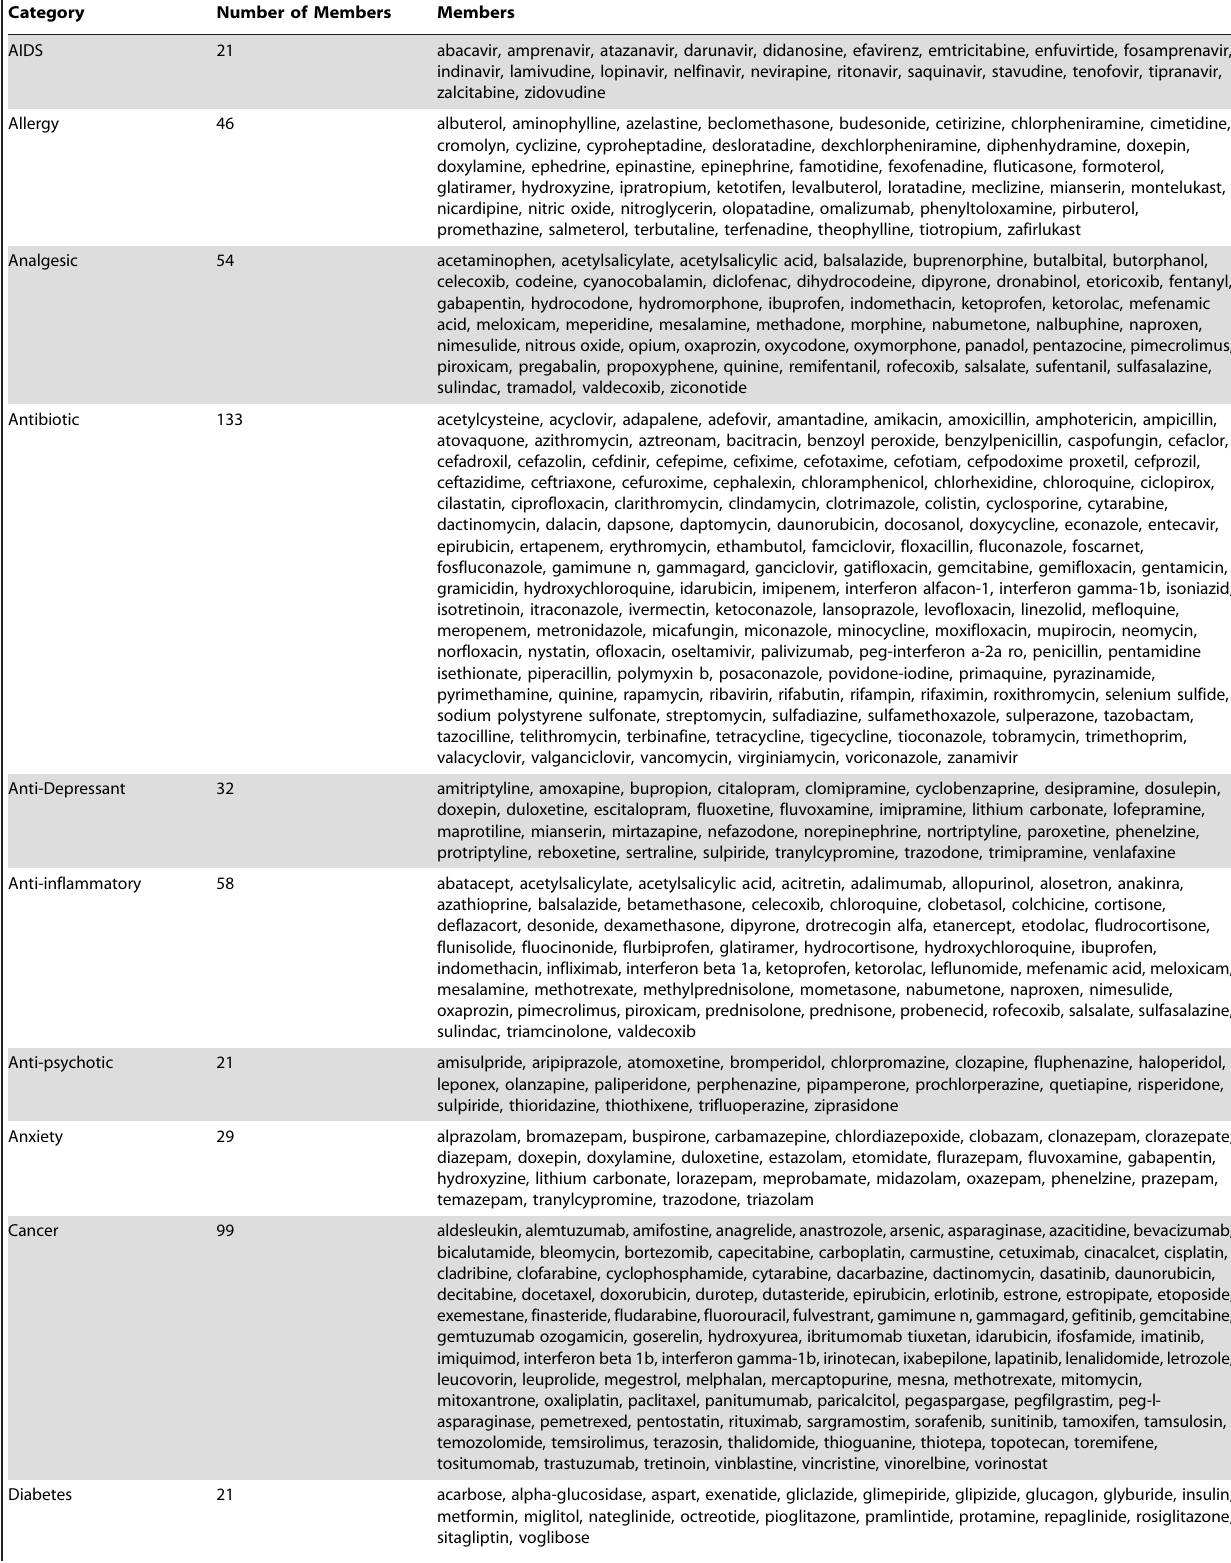
Table 2. Drugs by